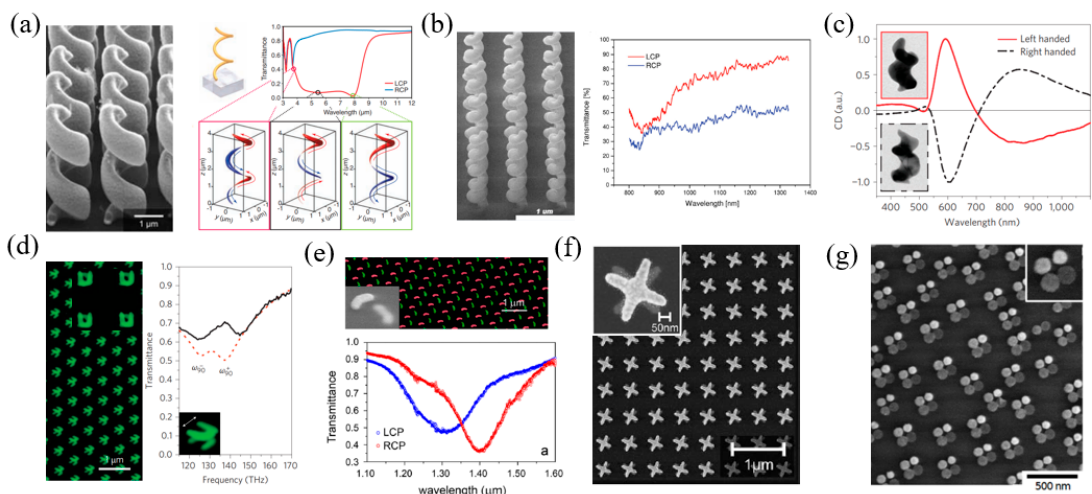
Figure 9. Chiral metamaterials fabricated by the top–down method. ( a ) Plasmonic helices fabricated by two-photon direct laser writing. The simulated transmittance spectra and plasmonic modes are depicted in the left panel. The incident LCP light is totally blocked, while RCP light is transmitted nearly without loss. Adapted from [65], with permission from © 2009 American Association for the Advancement of Science. ( b ) Helicoidal three-dimensional nanostructures fabricated by focused ion beam-induced deposition method; the spectrum shows strong chirality. Adapted from [72], with permission from © 2015, American Chemical Society. ( c ) Two symmetric pairs of gold spirals fabricated by the glancing angle deposition method, which exhibit a strong circular dichroism (CD) response in the visible wavelength range. Adapted from [73], with permission from © 2013, Springer Nature. ( d , e ) Field emission electron microscopy and transmission spectra of a double-layered twisted gold split ring ( d ) and twisted arc ( e ) metamaterial. ( d ) Adapted from [76], with permission from © 2009, Springer Nature; ( e ) Adapted from [78], with permission from © 2014, American Chemical Society; ( f ) Twisted stacked crosses. Adapted from [79], with permission from © 2009 The Optical Society of American. ( g ) Four particles of different heights form a chiral structure. Adapted from [81], with permission from © 2014, American Chemical Society.